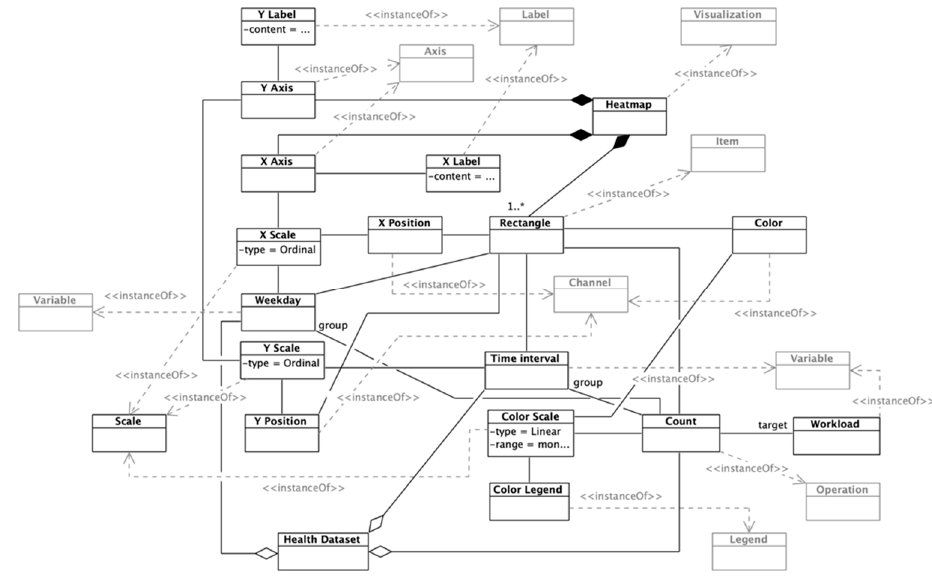
Figure 7. Dashboard meta-model instantiation regarding the heat map component.